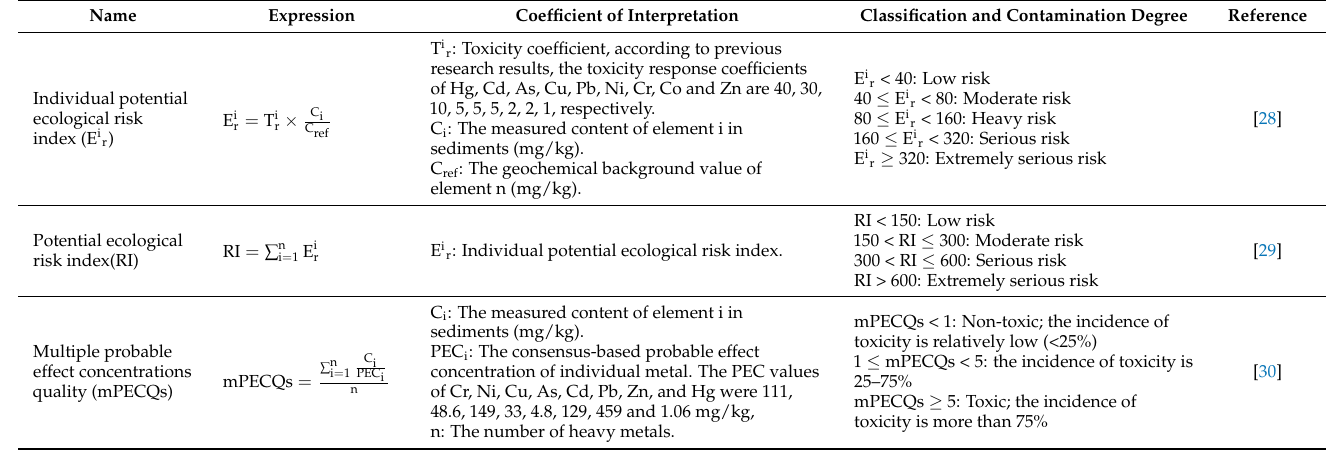
Table 1. Risk evaluation expression and physical significance.